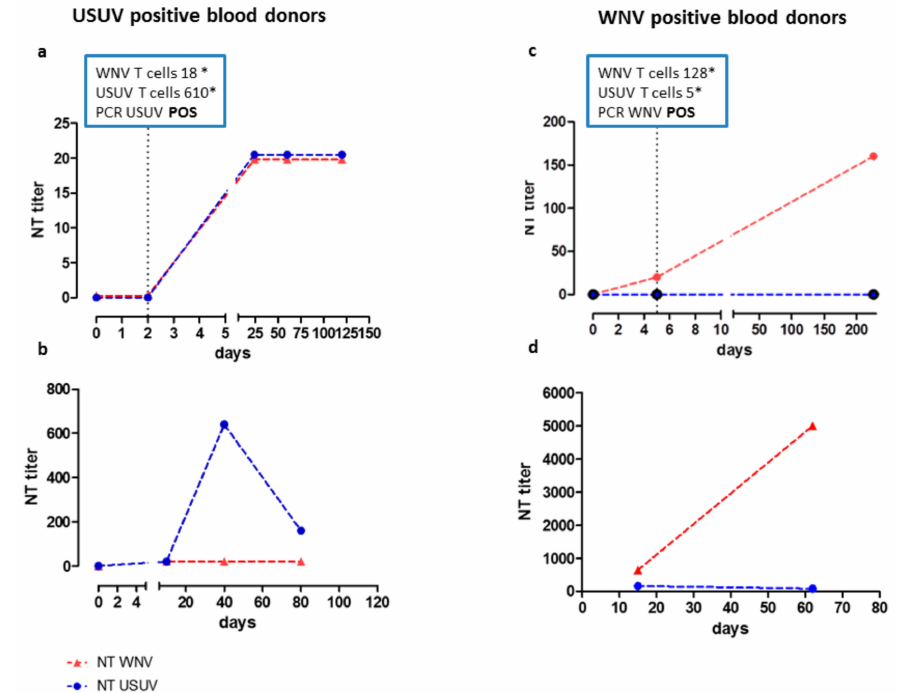
Figure 1. USUV and WNV NT antibodies in serum of two of the 13 blood donors with cross-reacting antibodies. Kinetics of WNV and USUV neutralization titer in two donors with true positive USUV infection followed for several months ( a , b ) and in two donors with true positive WNV infection ( c , d ) followed for several months are reported. If available, in the box, WNV and USUV ELISpot assay and PCR analysis results are reported. * net spots / million peripheral blood mononuclear cells